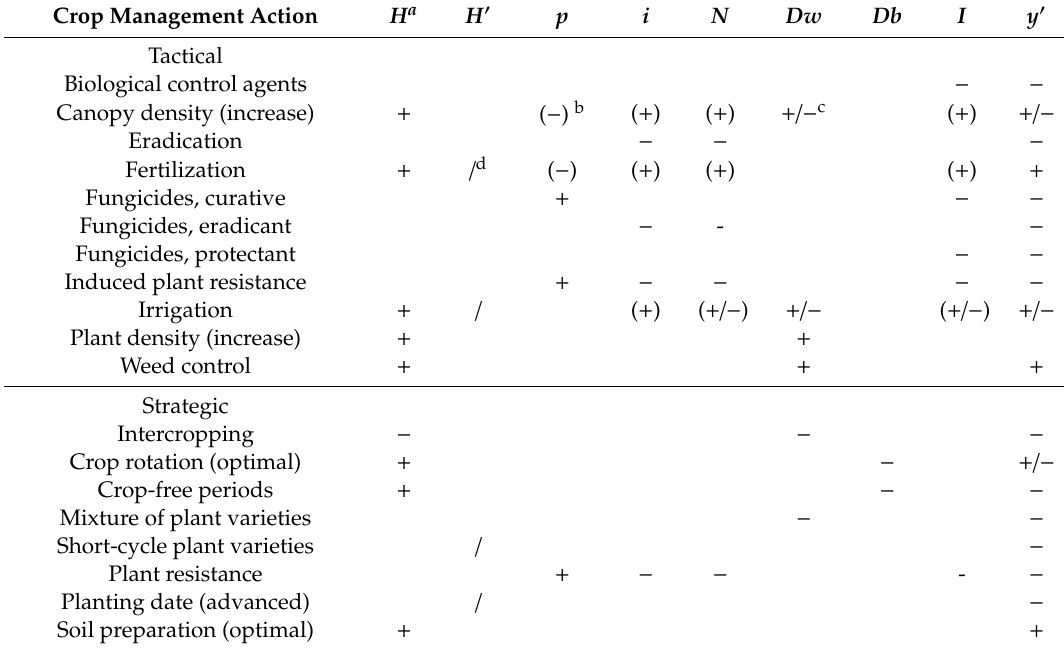
Table 3. Main e ff ects of crop management actions on increasing ( + ) or reducing ( − ) epidemiological parameters that a ff ect the rate of epidemic